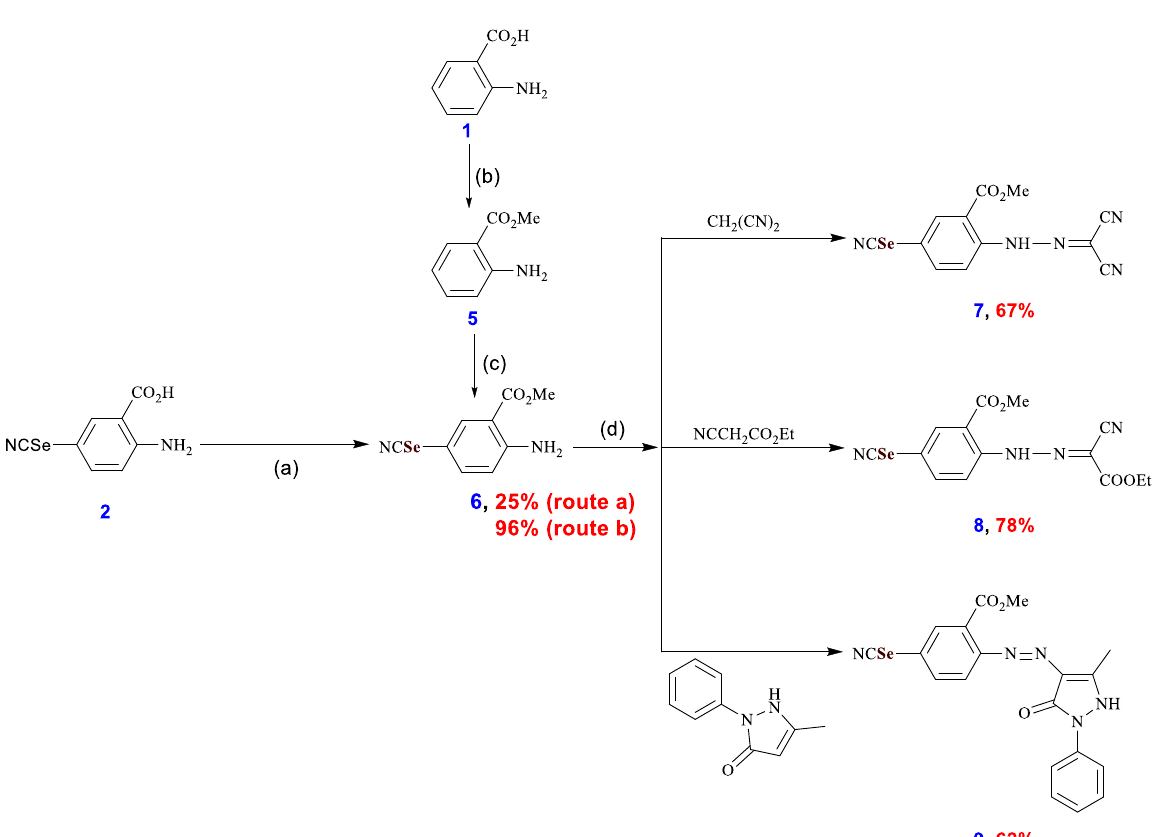
Scheme 2. Preparation of compounds 5 , 6 , 7 , 8 , and 9. Reagents and conditions: ( a )